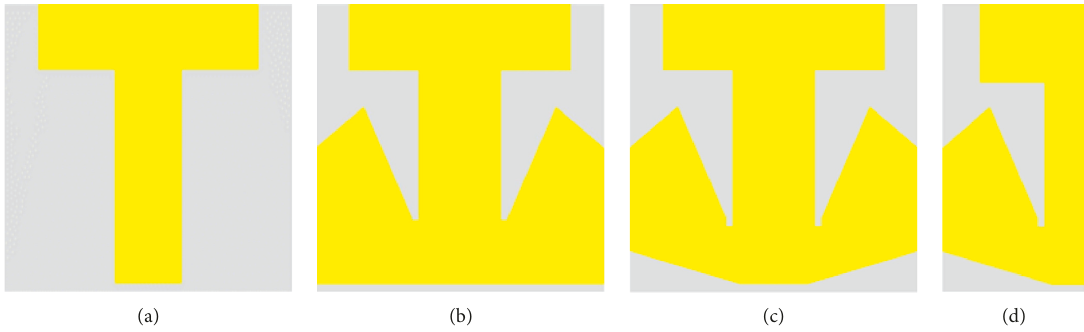
Figure 2: Evolutionary structure of printed monopole: (a) T-shaped monopole; (b) two-branch monopole; (c) tapered two-branch monopole; (d) tapered two-branch monopole after cutting it in half.